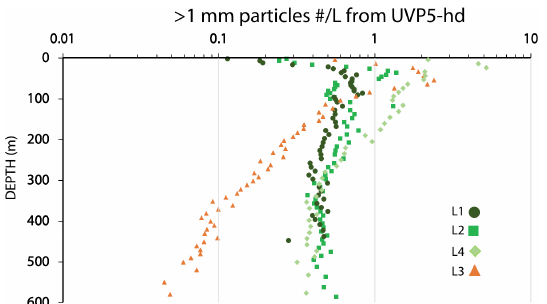
Figure 20. Mean non-living particle number concentrations for > 1 . 024mm sized aggregates from UVP5-hd profiles. Averages were from pooled CTD casts at filament locations L1, L2, and L4 and in transitional waters outside of the filament at L3. Aggregate num- bers were more abundant in the waters beneath the filament than in transitional waters below 100m, consistent with CFE